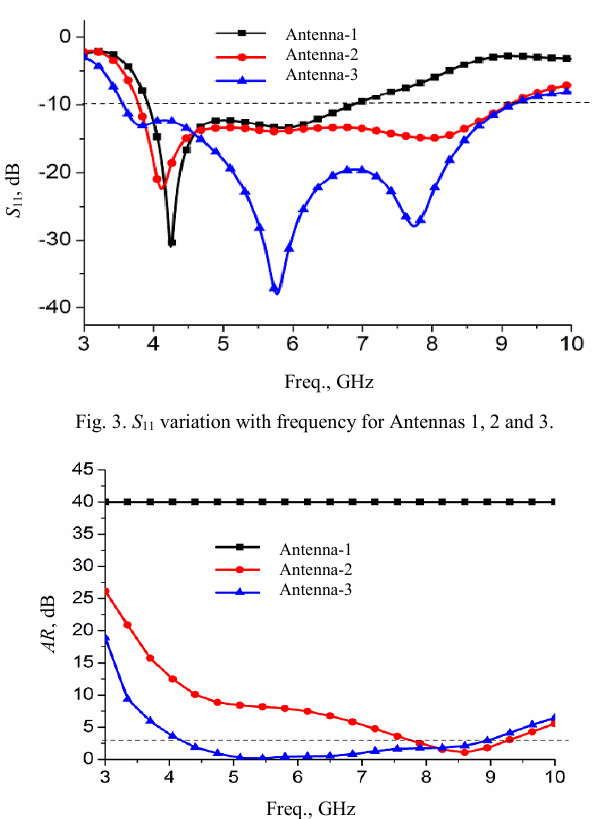
Fig. 4. Variation of AR value with frequency for Antennas 1, 2 and 3.